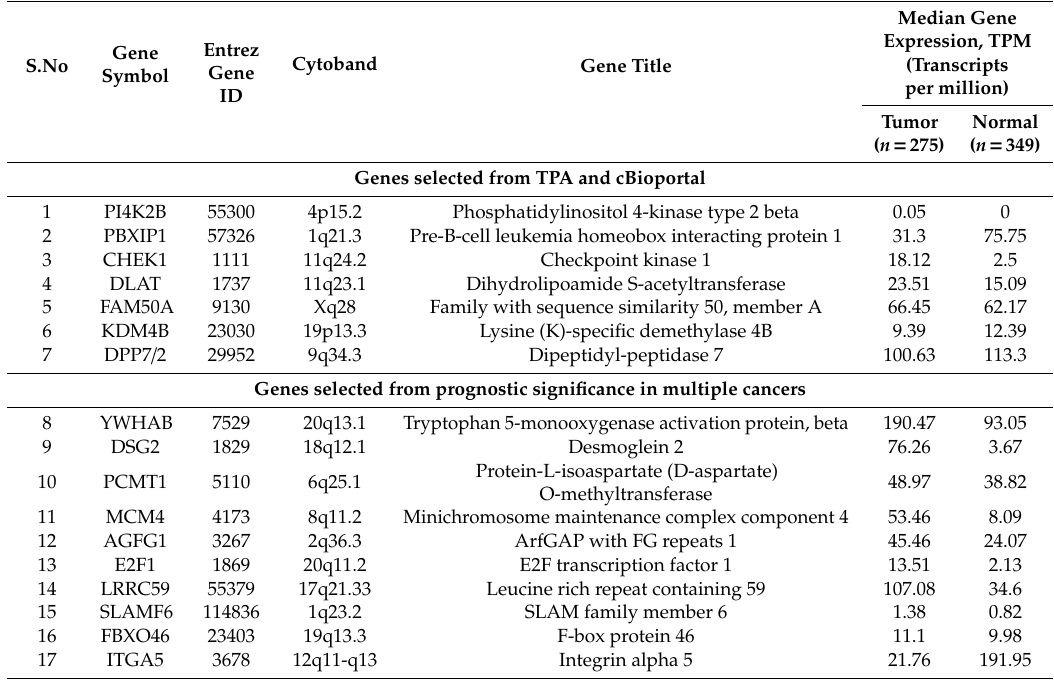
Table 1. The 17-gene panel included in this study along-with its expression variation in tumor and normal tissues as accessed from GEPIA portal.